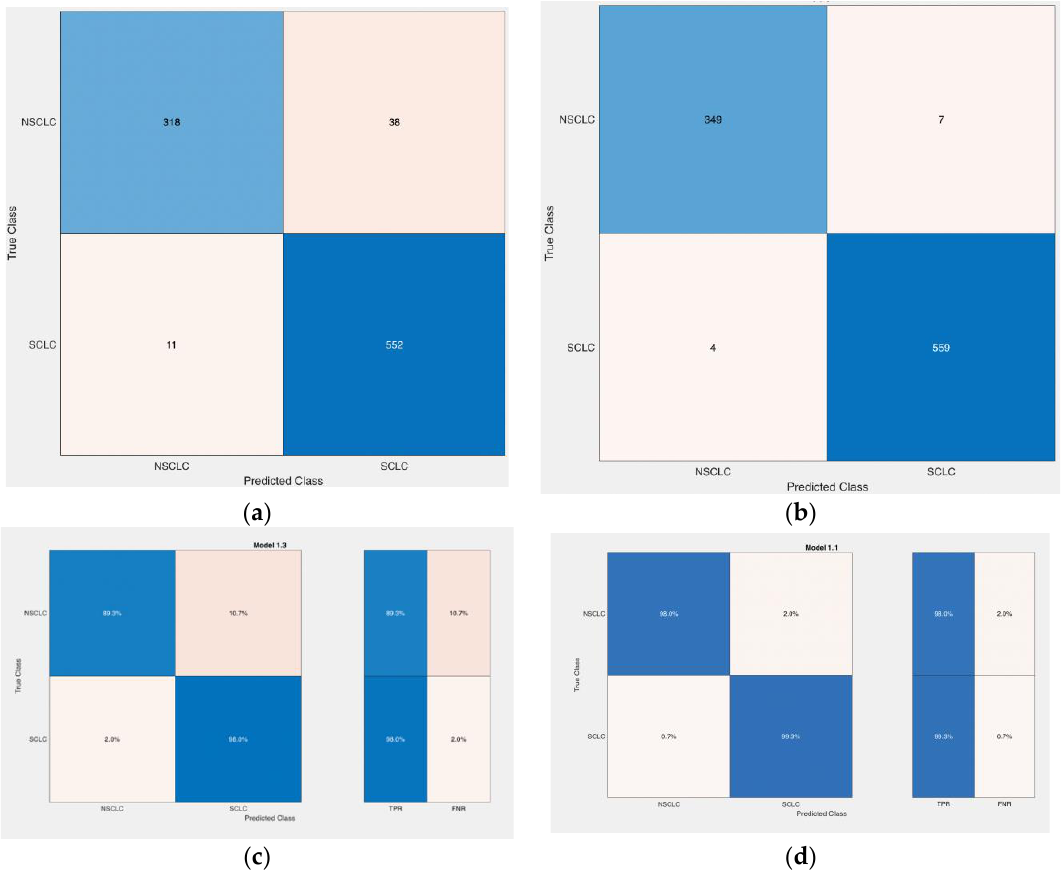
Figure 8. Lung cancer prediction performance based on gamma correction methods using DT course: ( a ) confusion matrix with gamma = 0.04, ( b ) confusion matrix with gamma = 0.5, ( c ) TPR (sensitivity) with gamma = 0.04, ( d ) TPR (sensitivity) with gamma = 0.5. Table 1 reflects the results based on data augmentation methods to avoid